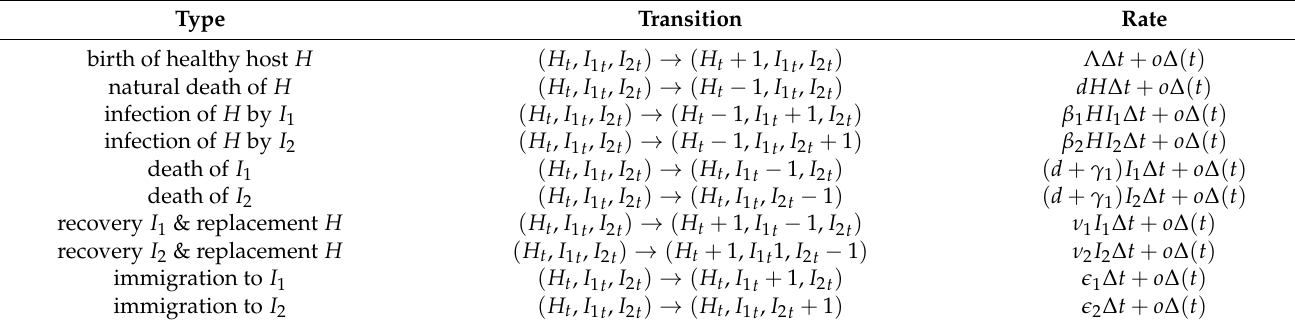
Table A1. Transitions rates of the model without quiescence